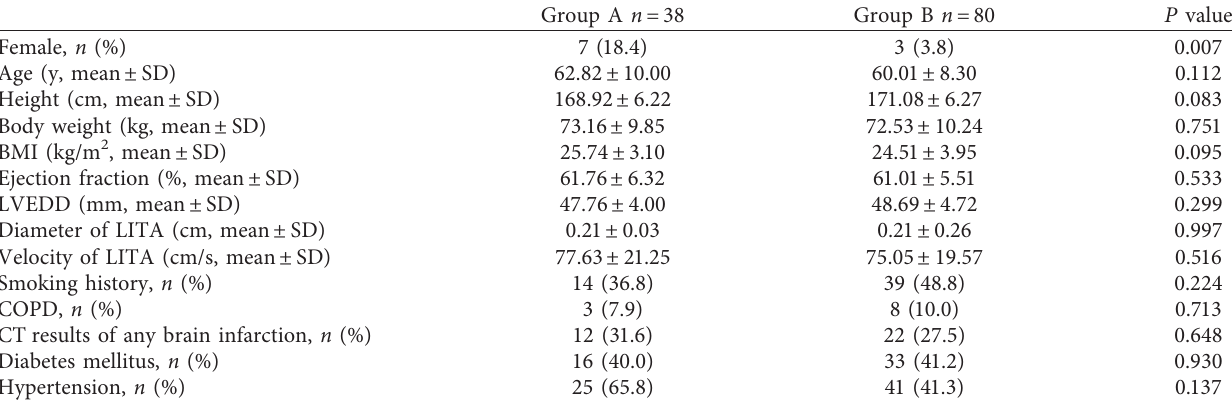
Table 3: Patients’ profiles with (group A) and without surgical challenges (group